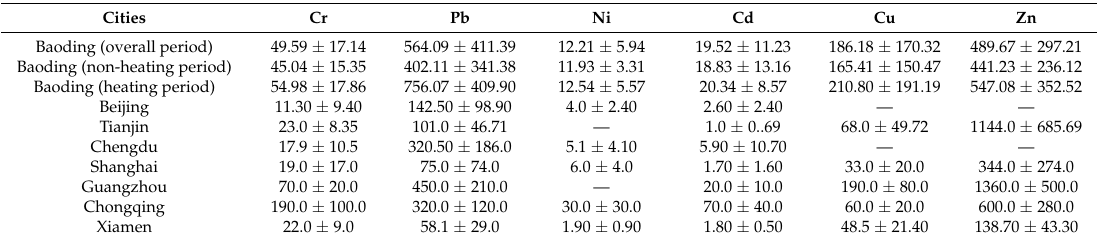
Table 6. Comparison of PM 2.5 -bound metals concentrations from different cities (ng · m − 3 ). Cities Cr Pb Ni Cd Cu Zn Baoding (overall period) 49.59 ± 17.14 564.09 ± 411.39 12.21 ± 5.94 19.52 ± 11.23 186.18 ± 170.32 489.67 ± 297.21 Baoding (non-heating period) 45.04 ± 15.35 402.11 ± 341.38 11.93 ± 3.31 18.83 ± 13.16 165.41 ± 150.47 441.23 ± 236.12 Baoding (heating period) 54.98 ± 17.86 756.07 ± 409.90 12.54 ± 5.57 20.34 ± 8.57 210.80 ± 191.19 547.08 ± 352.52 Beijing 11.30 ± 9.40 142.50 ± 98.90 — — Tianjin 23.0 ± 8.35 101.0 ± 46.71 — 1.0 ± 0..69 68.0 ± 49.72 1144.0 ± 685.69 Chengdu 17.9 ± 10.5 320.50 ± 186.0 5.1 ± 4.10 5.90 ± 10.70 — — Shanghai 19.0 ± 17.0 75.0 ± 74.0 6.0 ± 4.0 1.70 ± 1.60 33.0 ± 20.0 344.0 ± 274.0 Guangzhou 70.0 ± 20.0 450.0 ± 210.0 — 20.0 ± 10.0 138.70 ± 43.30 “—” represents no